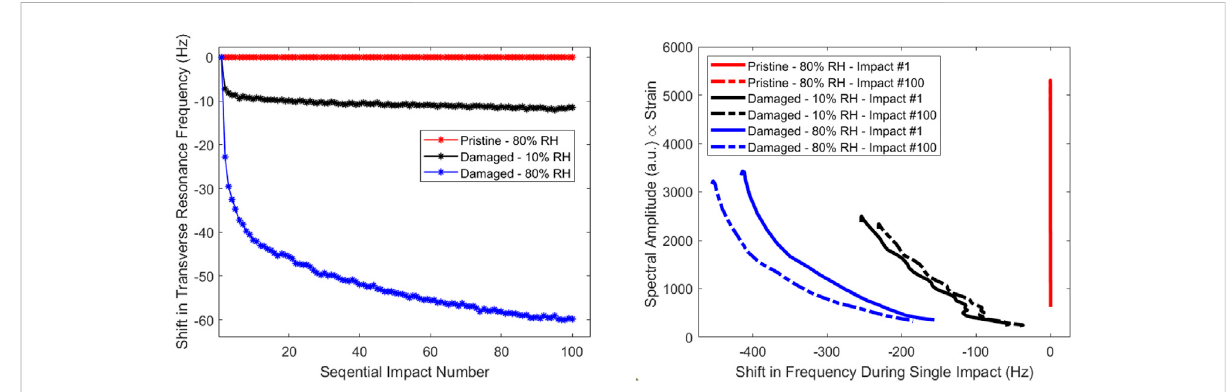
FIGURE 15 Sequential impact fundamental transverse resonant frequency shift in glass block sample for two damage states and two moisture states (left) and single-impact windowed frequency shift, NSIRAS, for the glass block sample calculated on the fi rst (001) and last (100) signal from sequential impact test set for different damage and moisture conditions